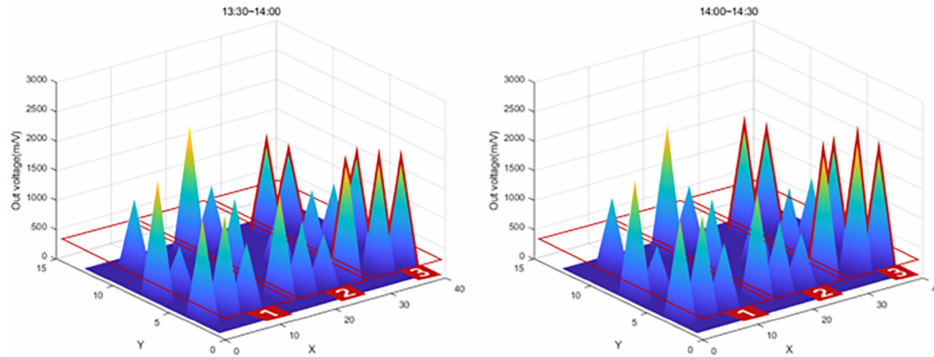
Figure 31. Sum of 3D graph values for data from 13:30~14:30.